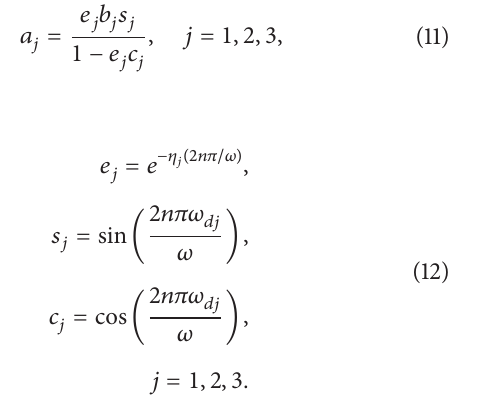
Figure 2: Grazing